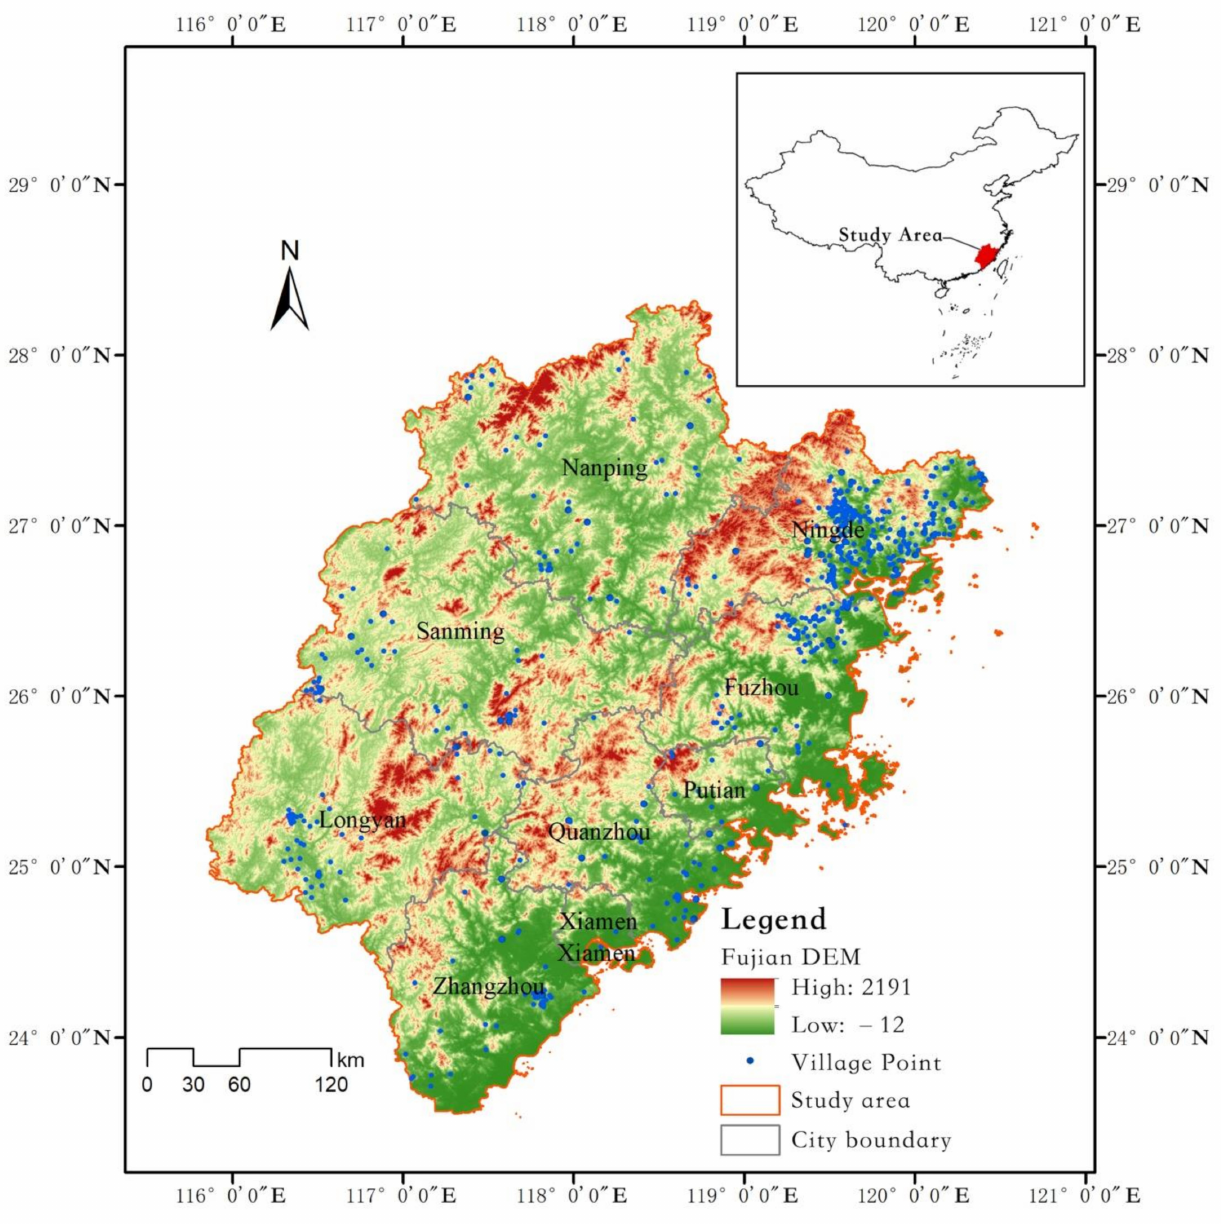
Figure 1. Location and topography of Fujian,